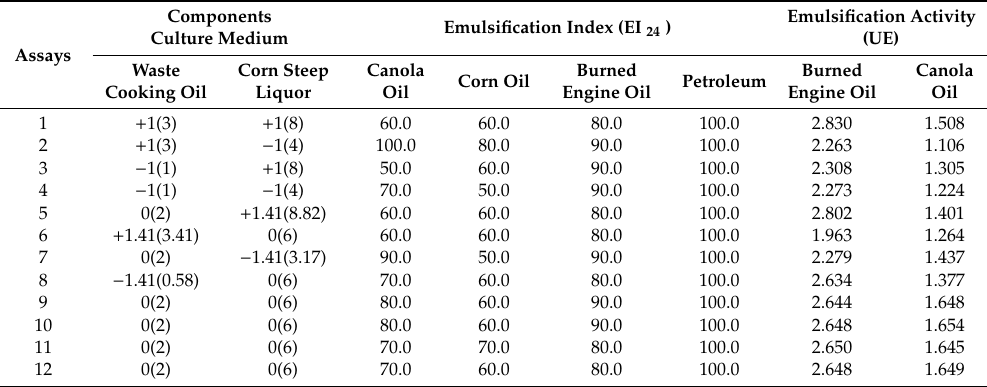
Table 2. RCCD 2 2 factorial design containing corn steep liquor and waste cooking oil as independent variables and results for variables responses on emulsification activity and emulsification